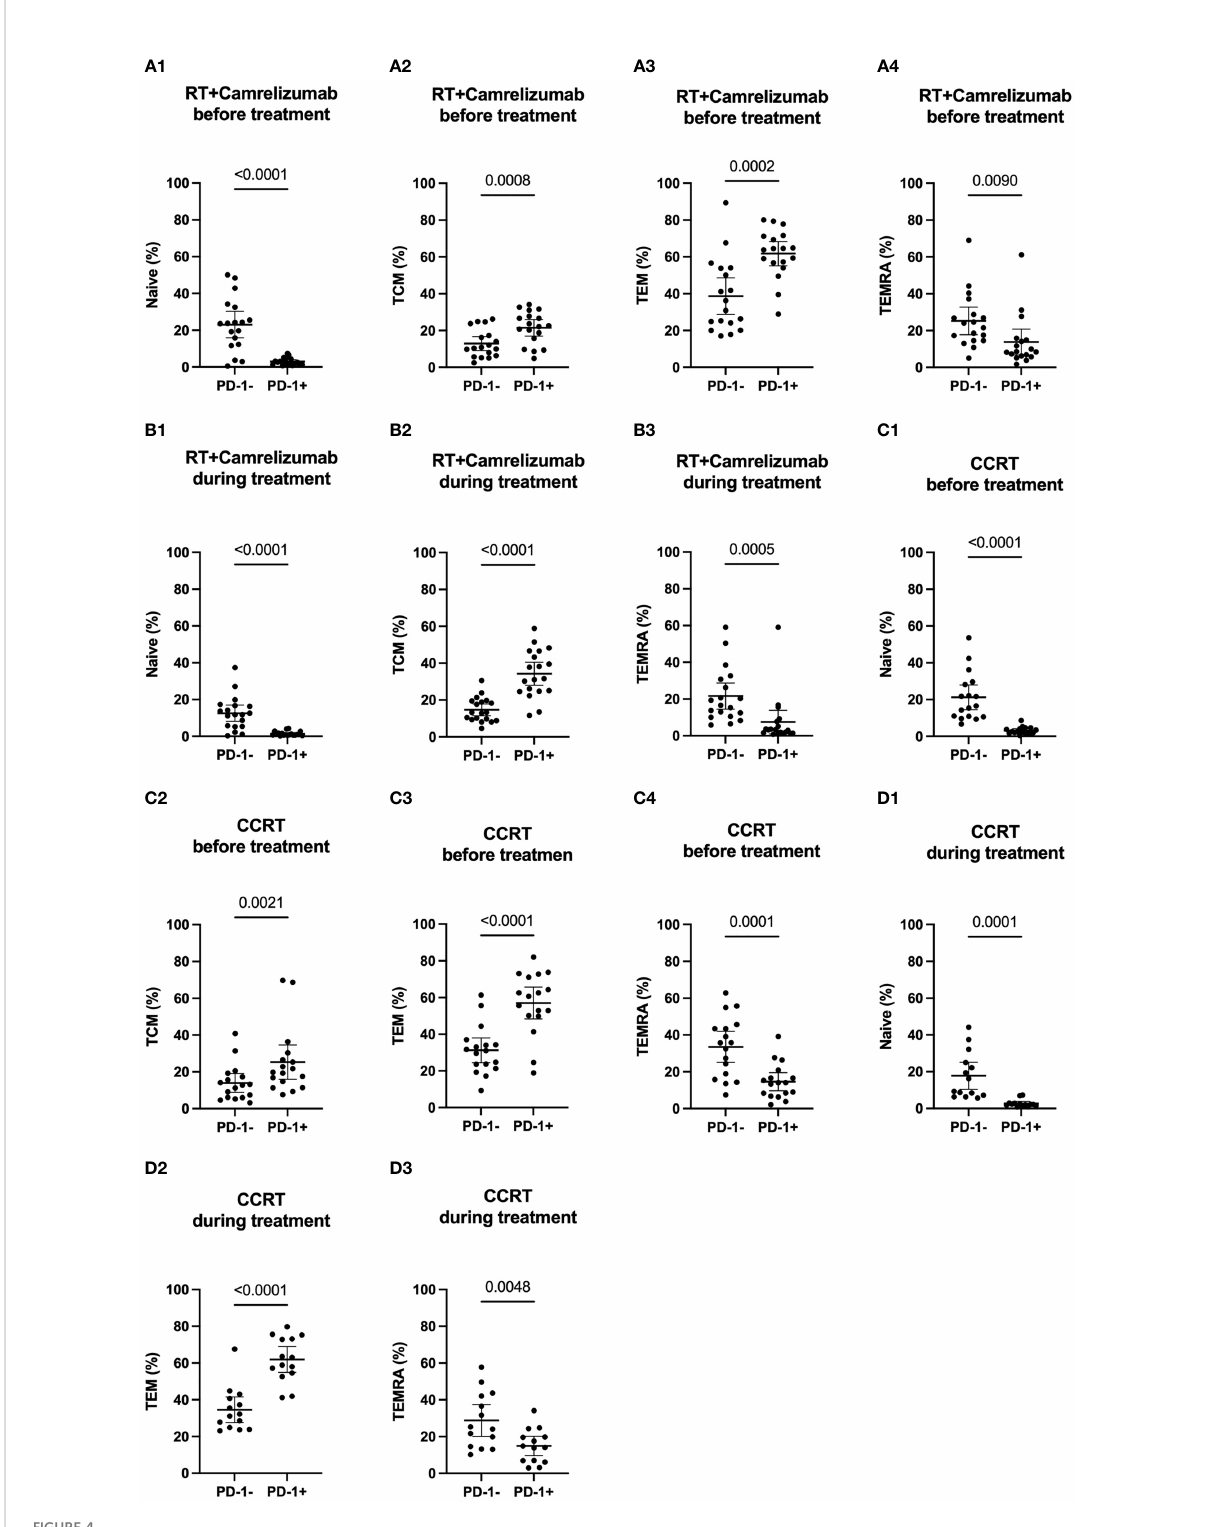
FIGURE 4 Differentiation subsets of PD-1 + and PD-1 - CD8 + T cells. (A) before RT plus immunotherapy treatment. (B) during RT plus immunotherapy treatment. (C) before CCRT treatment. (D) during CCRT